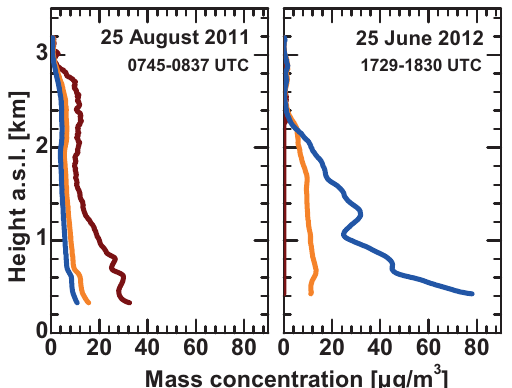
Figure 12. Particle mass concentration profiles (blue: spherical fine- mode particles, orange: fine-mode dust, dark red: coarse-mode dust) estimated from the particle extinction profiles in Figs. 10 and 11 after the method of Ansmann et al. (2012). Fine-mode and coarse- mode dust mass retrieval is described by Mamouri and Ansmann